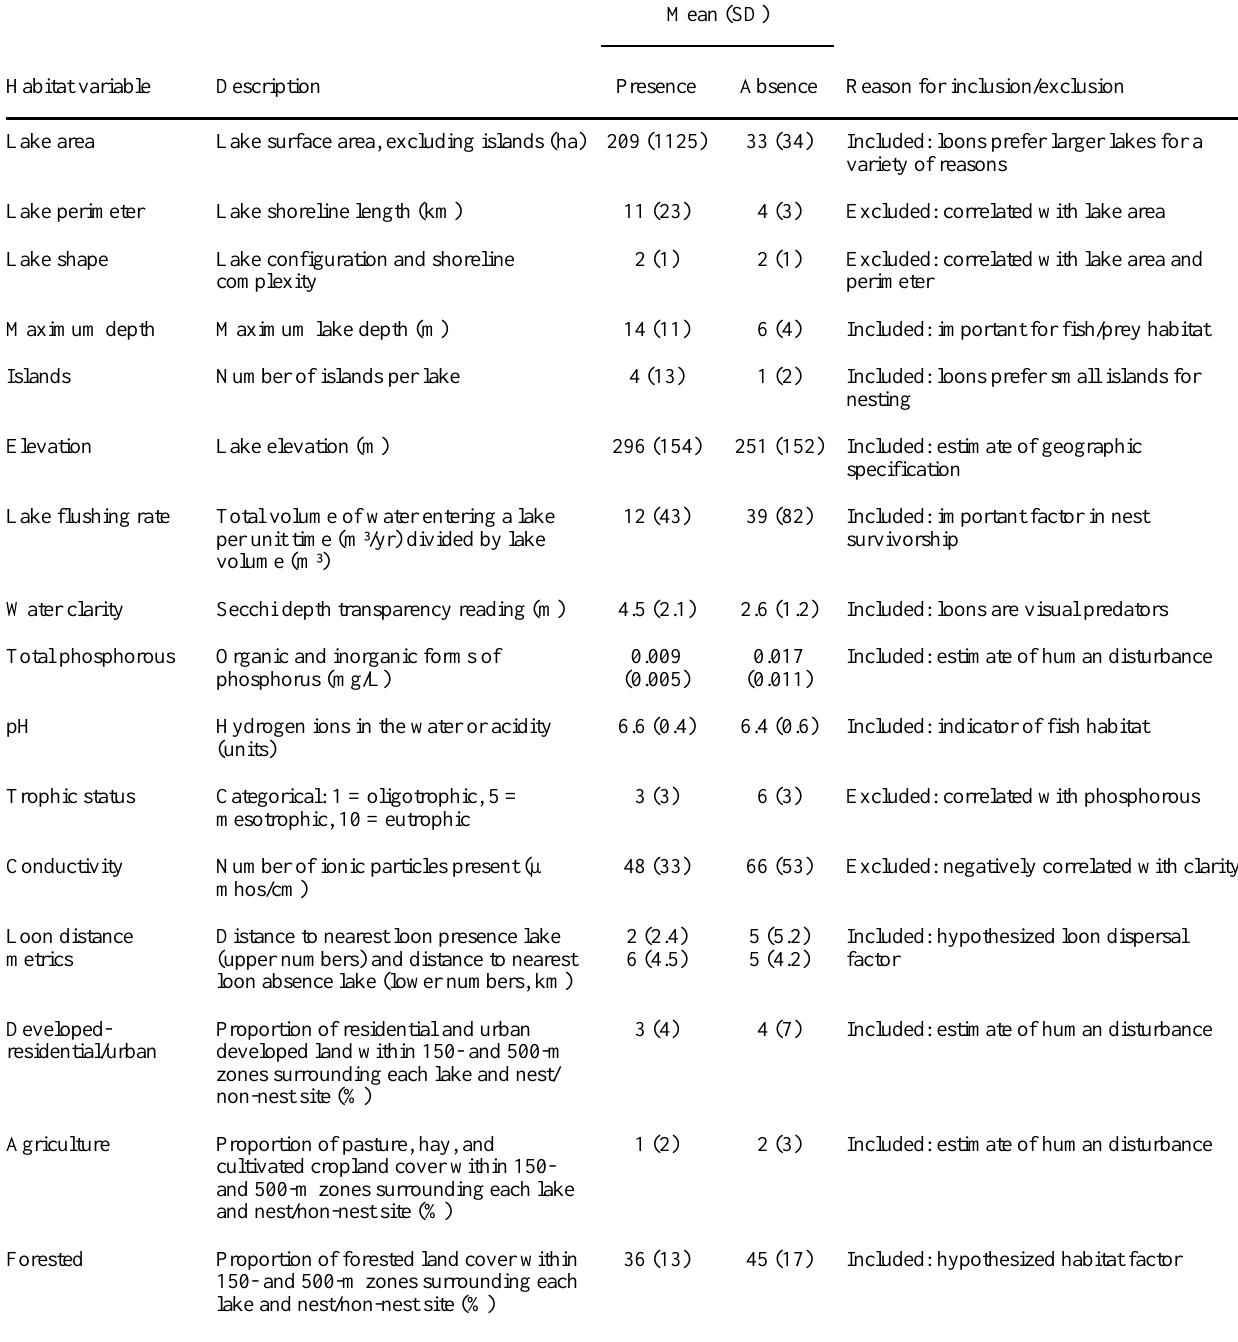
Table 2 . Summary of explanatory variables for breeding Common Loon presence and absence lakes across New Hampshire. N = 322 lakes. Means were measured for the 150-m zone surrounding each lake. All variables are included to highlight the range of variables considered during the modeling process. We modeled only variables indicated as included at each of the four scales within each ecoregion and